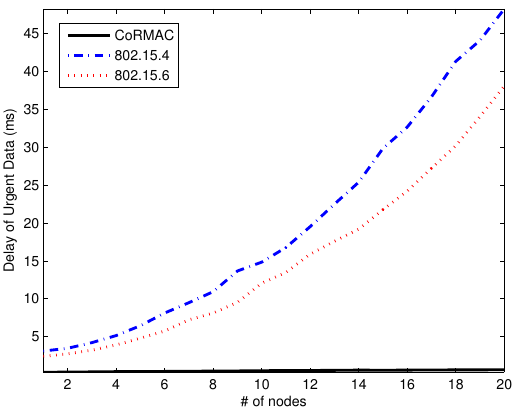
Figure 8. The average delay of urgent data vs. the number of